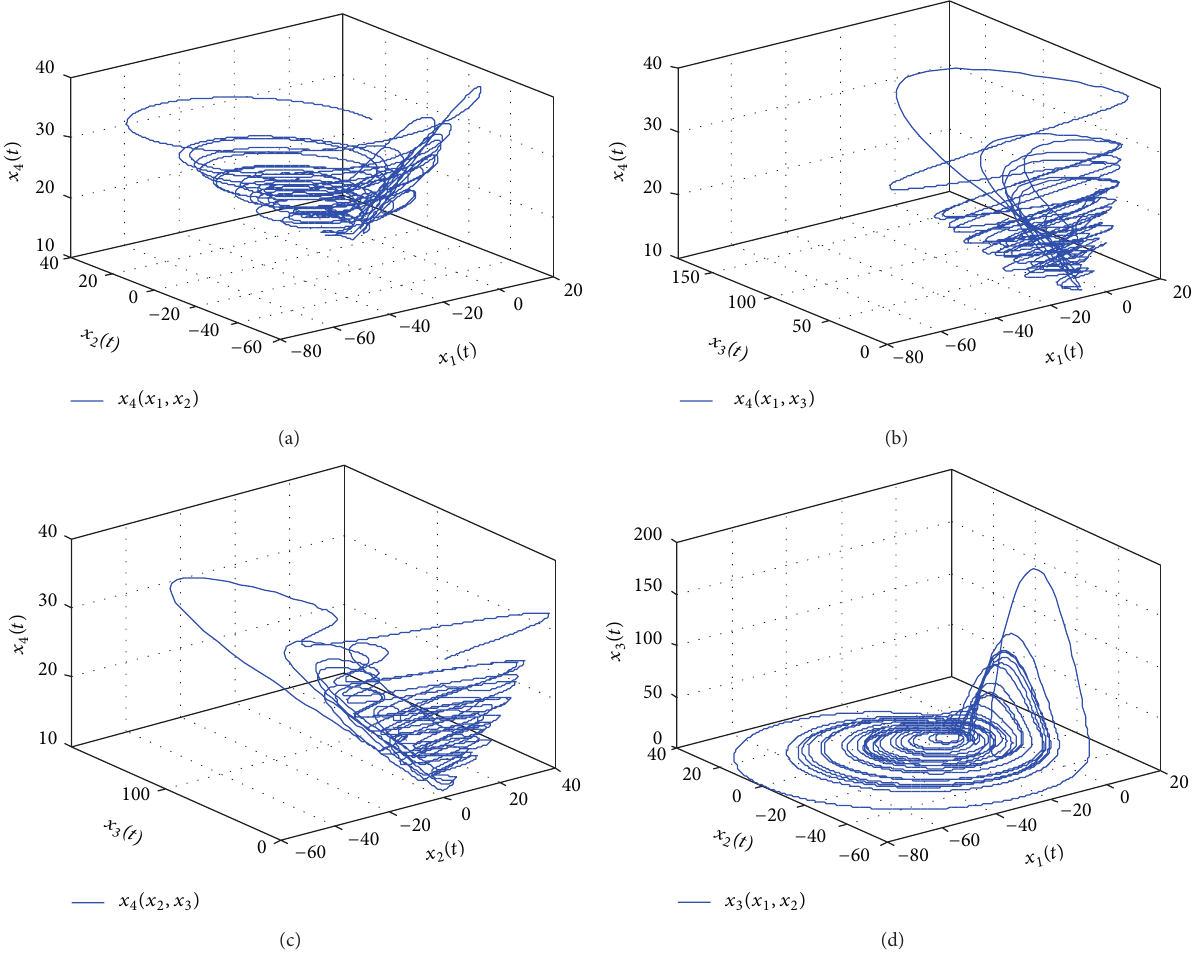
Figure 7: (a) Chaotic behavior 𝑥 4 (𝑥 1 (𝑡),𝑥 2 (𝑡)) of fourth Rossler fuzzy system. (b) Chaotic behavior 𝑥 4 (𝑥 1 (𝑡),𝑥 3 (𝑡)) of fourth Rossler fuzzy system. (c) Chaotic behavior 𝑥 4 (𝑥 2 (𝑡),𝑥 3 (𝑡)) of fourth Rossler fuzzy system. (d) Chaotic behavior 𝑥 3 (𝑥 1 (𝑡),𝑥 2 (𝑡)) of fourth Rossler fuzzy system.